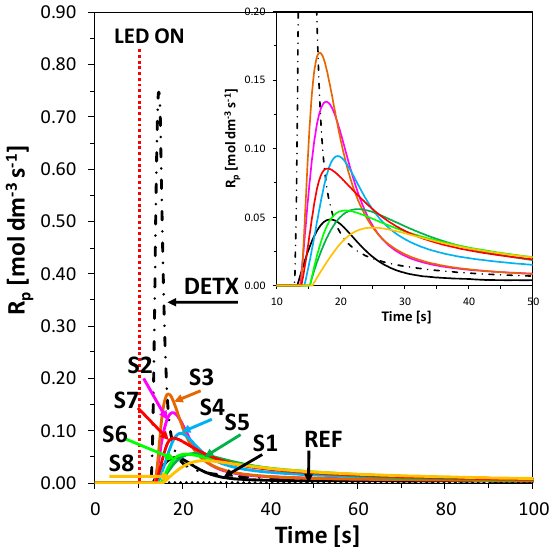
Time [s] Figure 13. Polymerization rate profiles for photopolymerization of CADE with HIP (1 wt.%) and 2-amino-4,6-diphenyl-pyridine-3-carbonitrile derivatives (0.1 wt.%) under 405 nm LED (intensity at the surface of sample 25 mW/cm 2 ) irradiation, calculated from photo-DSC data. Irradiation begins at t = 10 s.